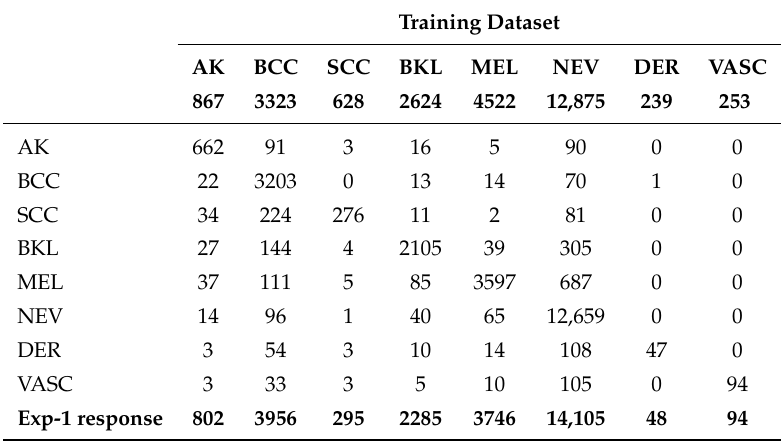
Table 2. Confusion matrix of the Exp-1 with α = − 2.0. The dataset has 25,331